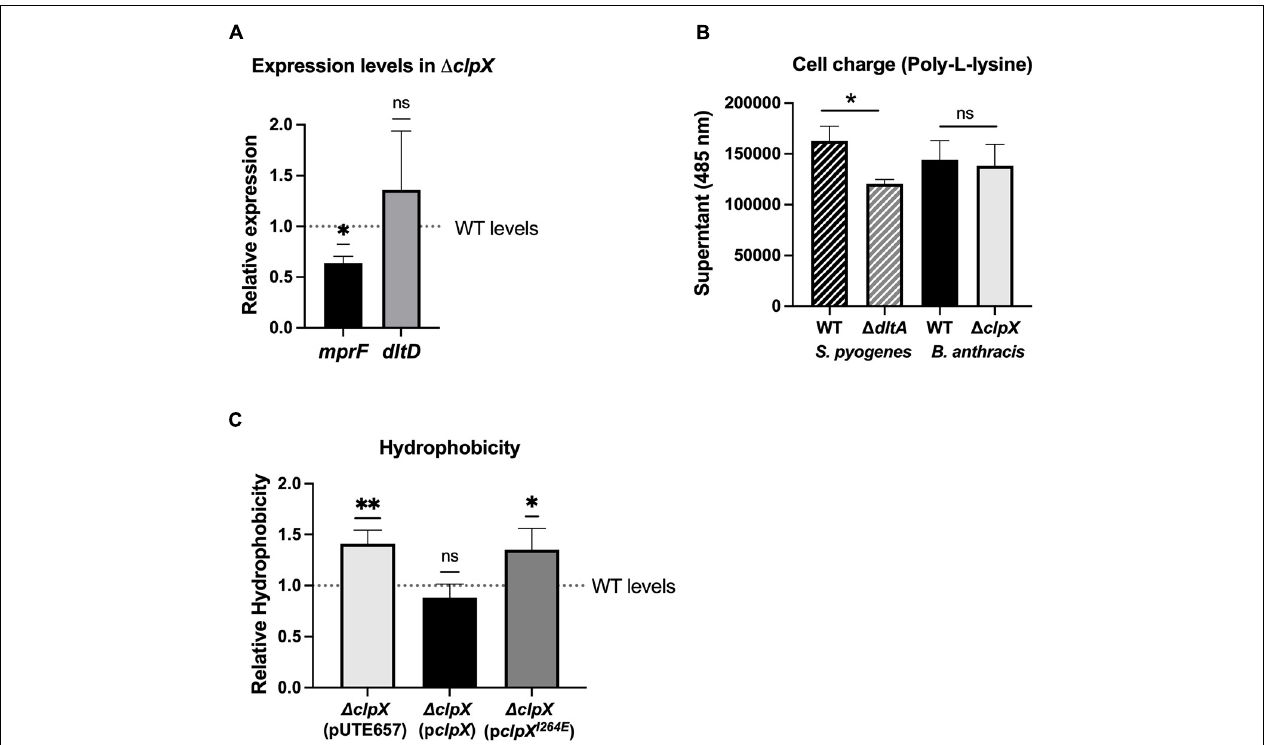
FIGURE 6 | (cid:49) clpX has increased hydrophobicity but no changes in cell charge. (A) Expression levels of the mprf and dltD genes in (cid:49) clpX relative to wild-type (WT) levels (dotted line). * p < 0.05 as determined by a one-sample t -test. (B) Amount of cationic poly- L -lysine that sequesters in the supernatant after incubation with WT S. pyogenes , WT B. anthracis Sterne or their respective mutants (cid:49) dltA and (cid:49) clpX . * p < 0.05 as determined by unpaired t -test between WT and mutant of each species. (C) Amount of the (cid:49) clpX mutant containing the empty plasmid (pUTE657), and (cid:49) clpX complemented with either the wild-type clpX gene (p clpX ) or the clpX gene containing the I264E point mutation (p clpX I 264 E ) that sequesters in n-hexadecane relative to the WT strain (dotted line). * p < 0.05, ** p < 0.01 as determined by a one-sample t -test. Data presented as mean ± SD from at least three independent